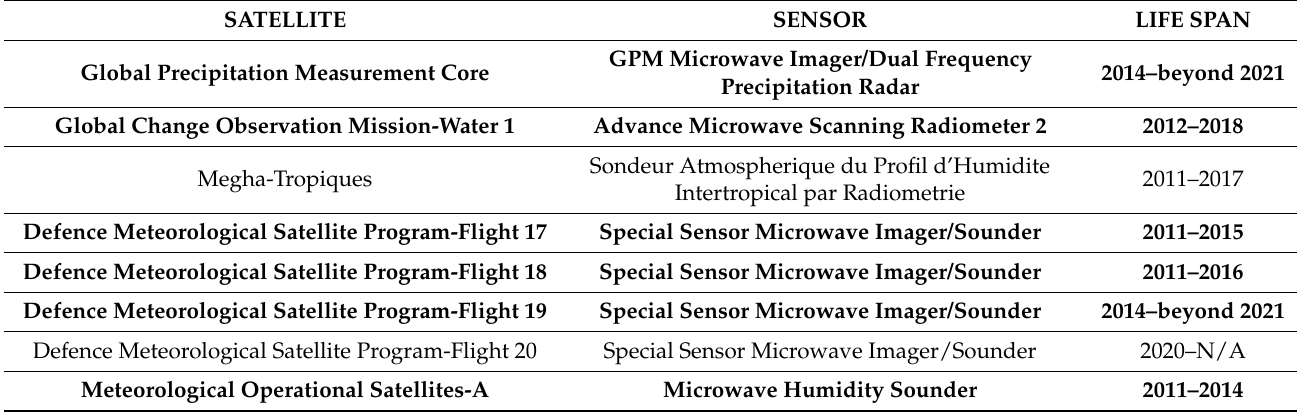
Table 1. Launch schedules and life spans of Global Precipitation Measurement constellation satellites. Satellites used in this study are in